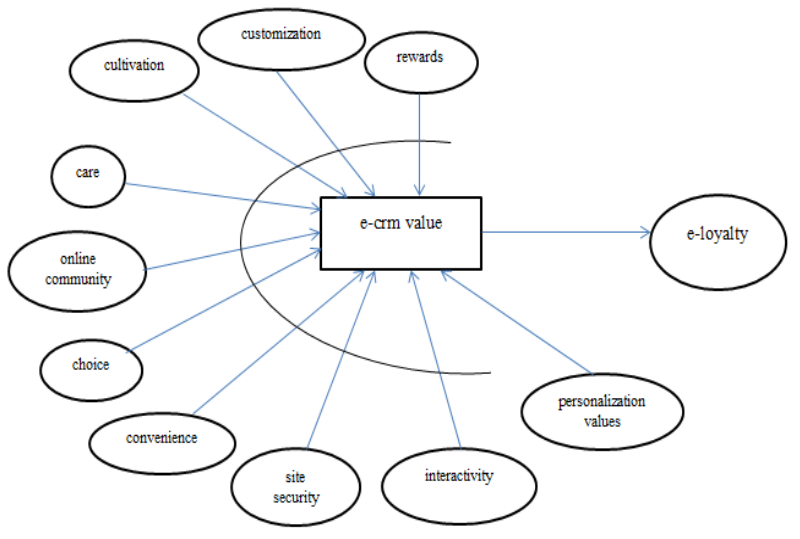
Figure 1. Research framework.